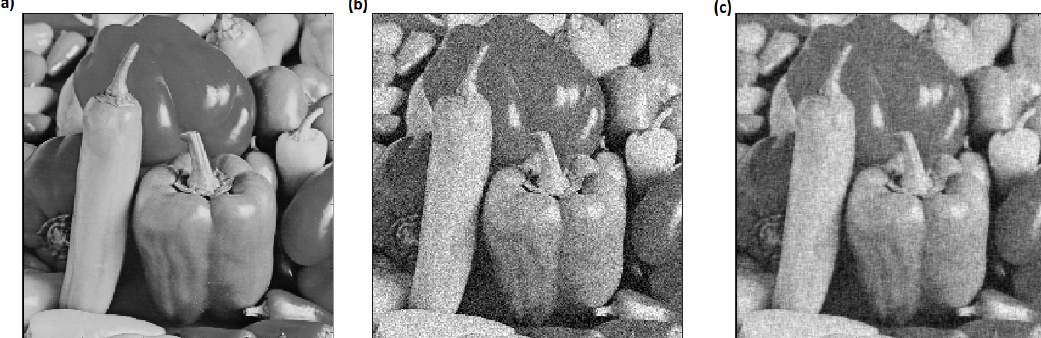
Figure 19. ( a ) Original image, ( b ) Image with the addition of Gaussian white noise (Input PSNR = 18.59 dB), ( c ) Denoising with proposed method (Output PSNR = 24.59 dB).